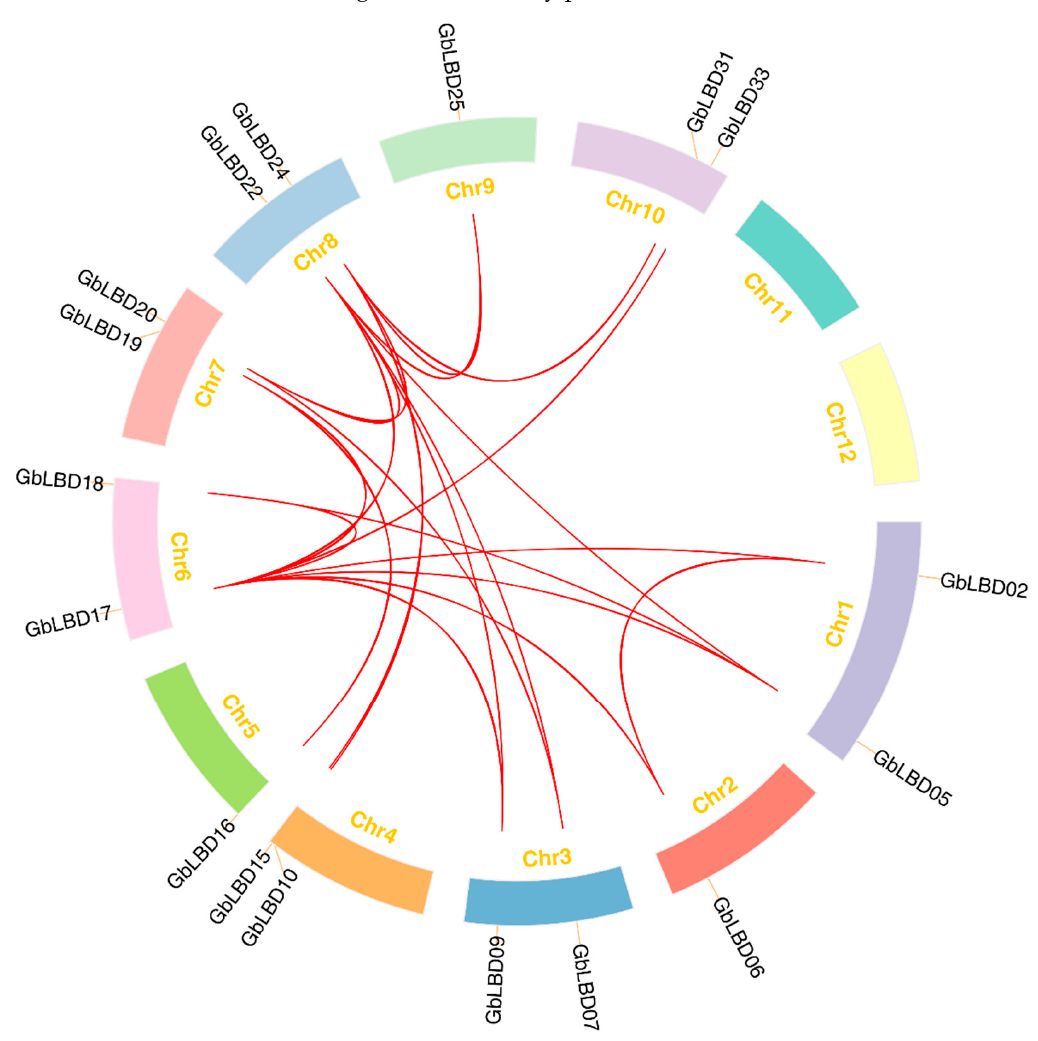
Figure 4. Distribution and synteny of GbLBD gene family in ginkgo genome. The red line connects repeated pairs of GbLBD genes.